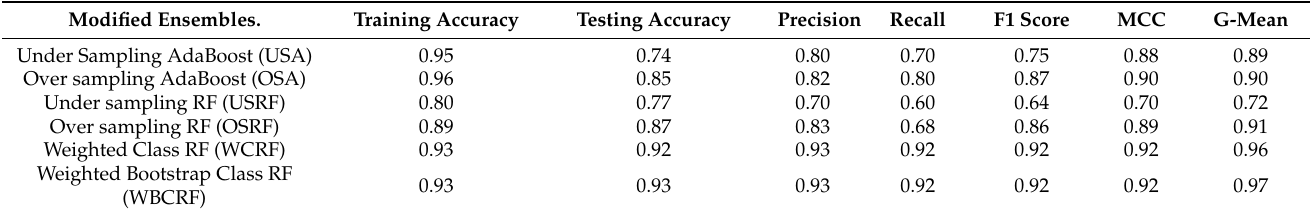
Table 6. Modified ensemble classifiers for the classification of imbalanced drilling data. Modified